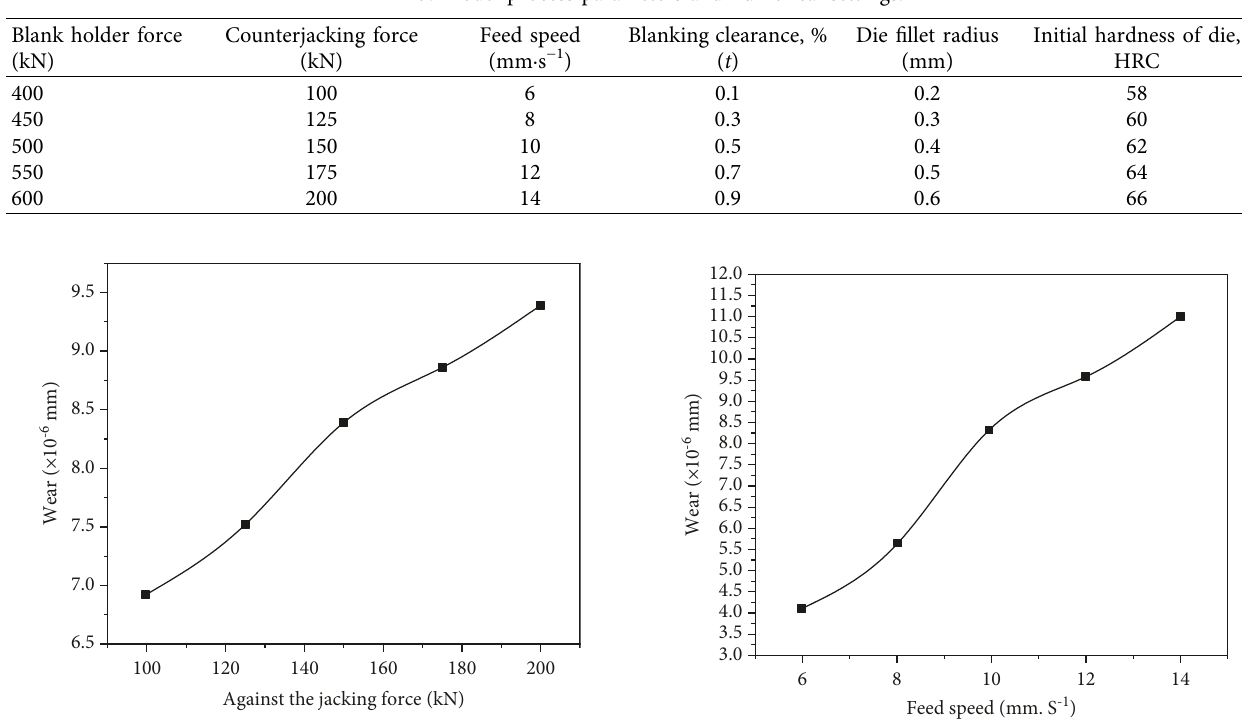
Figure 3: Effect of antijacking force on die wear.